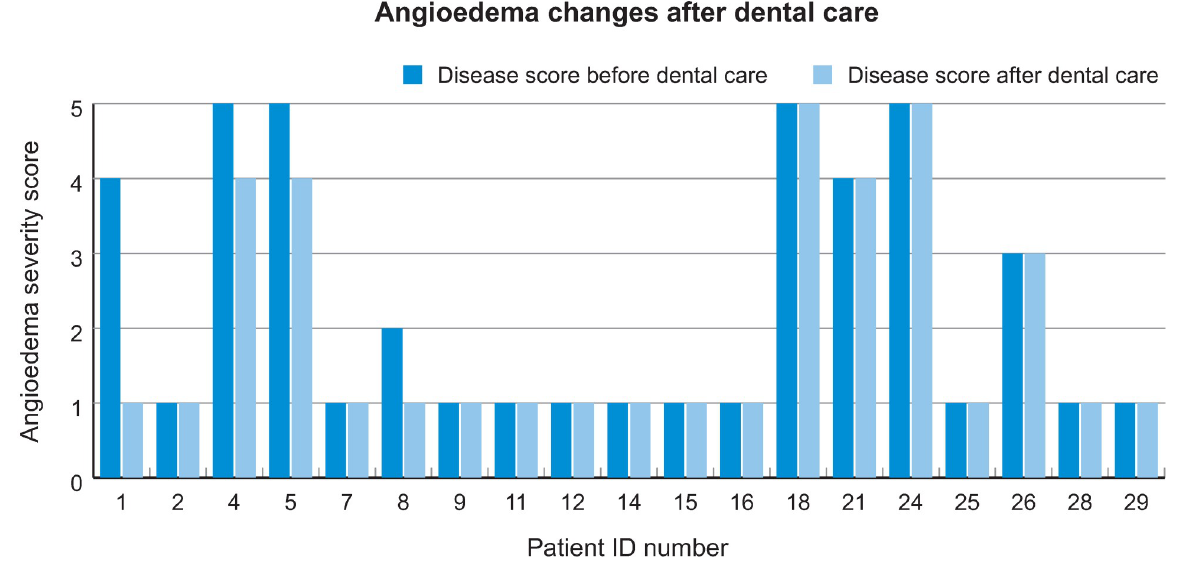
Fig 2. Angioedema severity before and after dental procedures (refer to our score in Table 2).